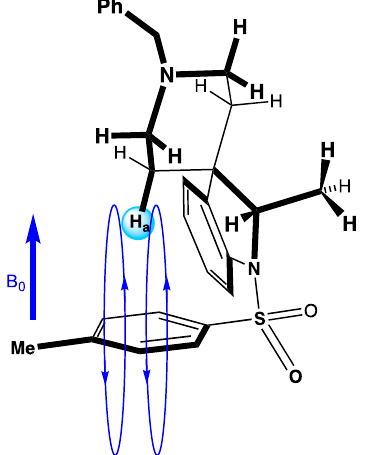
Figure 2. Upfield Shift of Ha in the 1 H NMR of Spiropiperidine 27 due to Diamagnetic Anisotropy from the Sulfonamide -System.